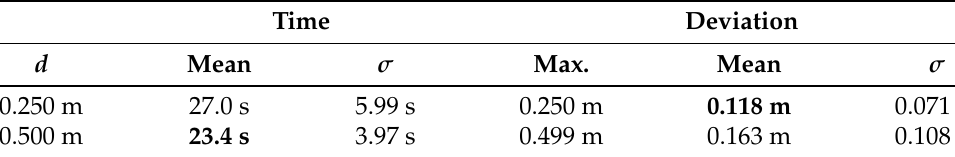
( c ) Trajectory percentage with d = 0.500 m ( d ) Trajectory deviation with d = 0.500 m Figure 8. Trajectory percentage and deviation of two transportation processes. Table 2. Results of the experiment grouped by maximum